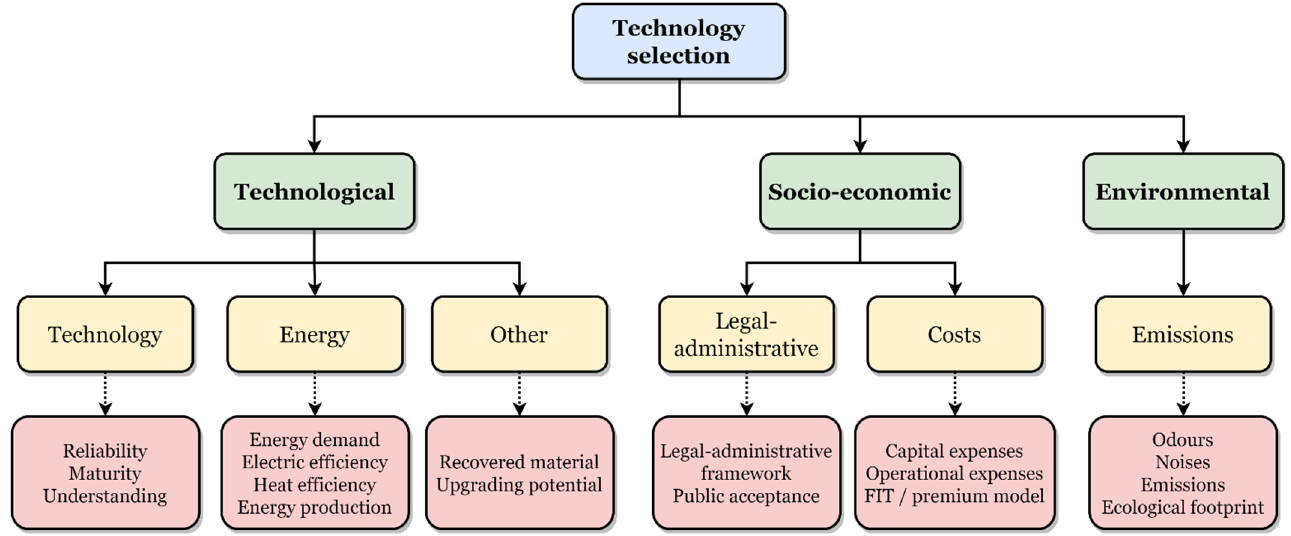
Figure 2. The criteria hierarchy used for assessment and comparison of sludge treatment methods.